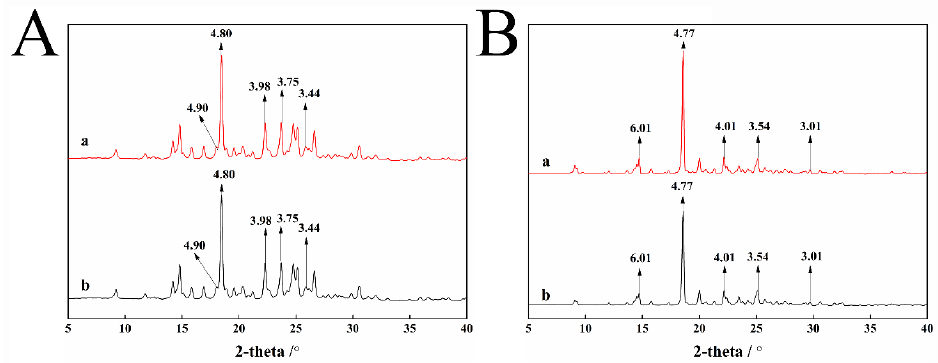
Figure 2. XRD results of pyraclostrobin crystal II ( A - a ) and adsorbed dispersant 2700 ( A - b ), pyraclostrobin crystal IV ( B - a ) and adsorbed dispersant 2700 ( B - b ).